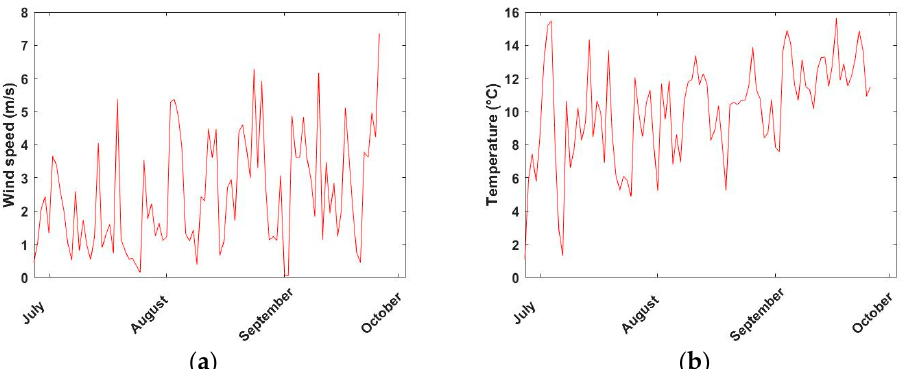
Figure 2. Time series of temperature and wind speed (each average of data between 8:00 to 9:00) over the three-month period of data collection in Motat Ews Station (Retrieved from NIWA [29]) ( a ) wind speed ( b ) temperature.